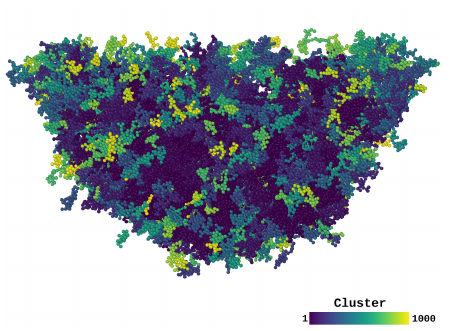
Figure 7. Clusters of atoms with high NASD > NASD cutoff ; these clusters constitute the STZs. Clusters are ordered by size; the largest cluster is dark blue and the smallest cluster is yellow. Only the 1000 largest clusters are shown. Parameters: T = 0.1 K, NASD cutoff = 20 Å 2 and σ = 2.48 Å.